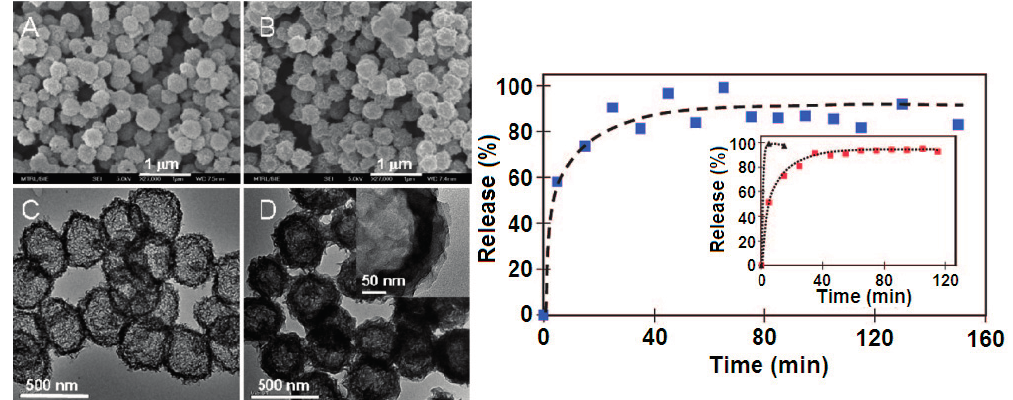
Figure 9. ( Left ) Scanning electron microscopy (SEM) ( A ) and transmission electron microscopy (TEM) ( C ) of metal oxide hollow nanospheres obtained after calcinations of LDH - NCs (nanocrystals)/central nervous system (CNS) composite and SEM ( B ) and TEM ( D ) of ibuprofen (IBU) - LDH hollow nanospheres after reconstruction; ( Right ) In vitro release profile of IBU from IBU-LDH hollow nanospheres in a buffer solution pH 7.0. The inset shows the release profiles from IBU–LDH nanoplates ( ■ ) and IBU sodium salt ( ▲ ) under the same conditions. Modified with permission from [42] (Copyright 2009 American Chemical Society).